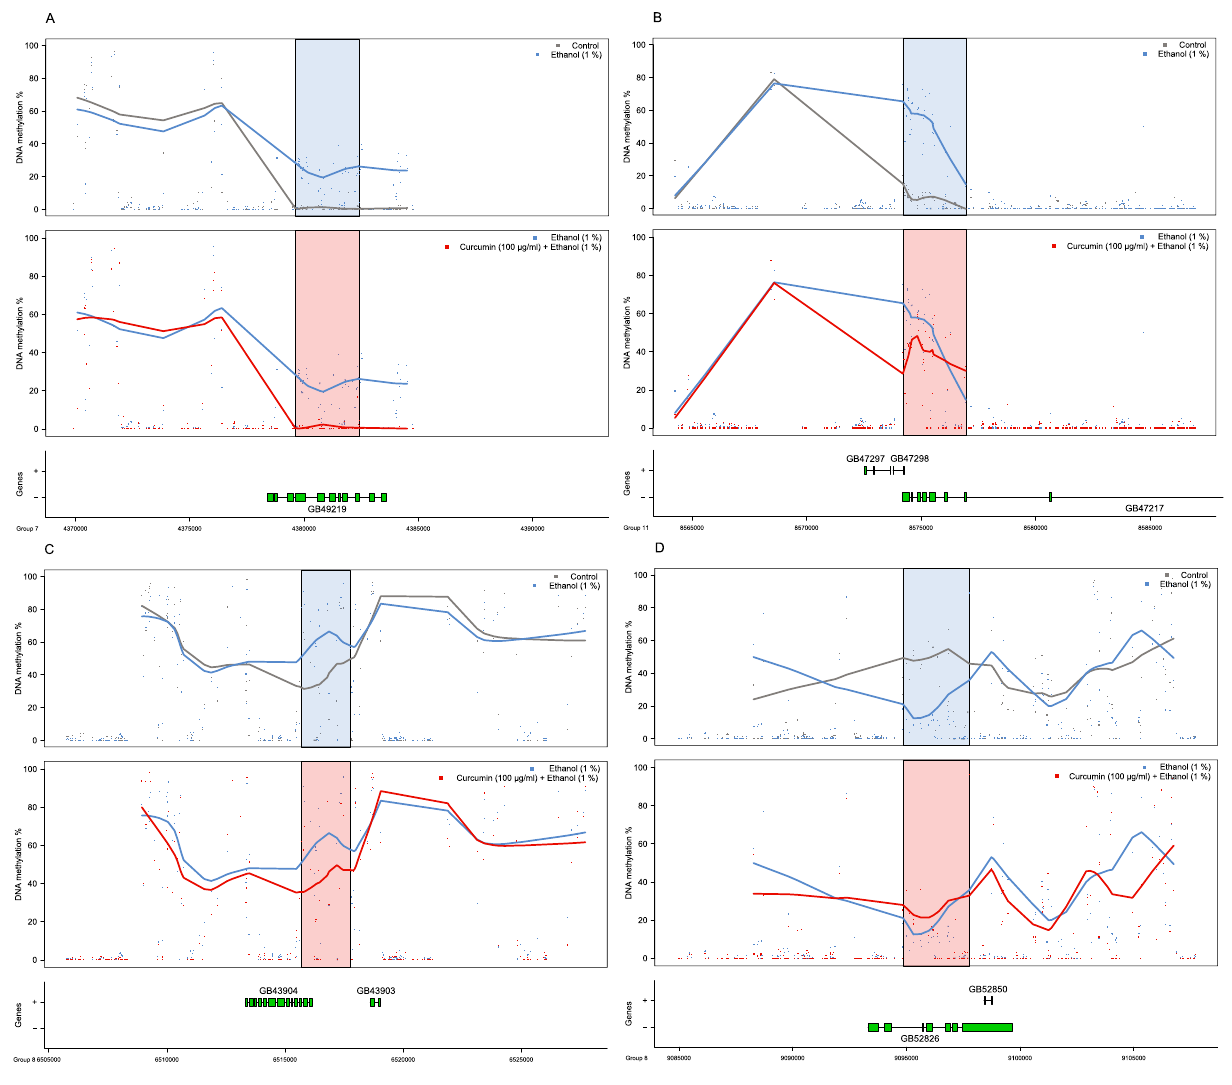
Figure 3. ( A – D ) Differentially methylated regions where the top panel depicts the situation in control (grey) versus ethanol (blue) fed honey bees, and the blue shaded area indicates the significant DMR. 10 kbp upstream and downstream (if no gaps exist in the Amel 4.5 genome build) are plotted for reference (white background). The middle panel depicts the comparison between ethanol-only (blue) and the honey bee group fed ethanol and curcumin (red). The lower panels depict the gene structure by exons (boxes) and introns (lines) by strand according to linkage